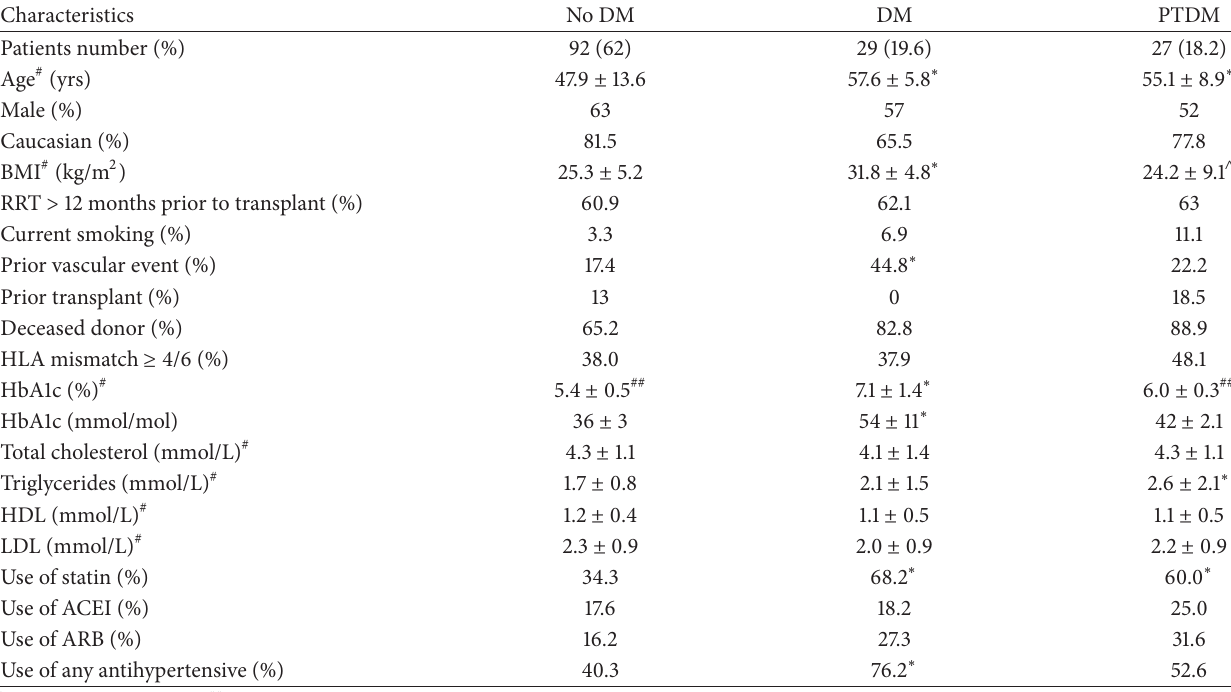
Table 1: Patient characteristics prior to transplantation.